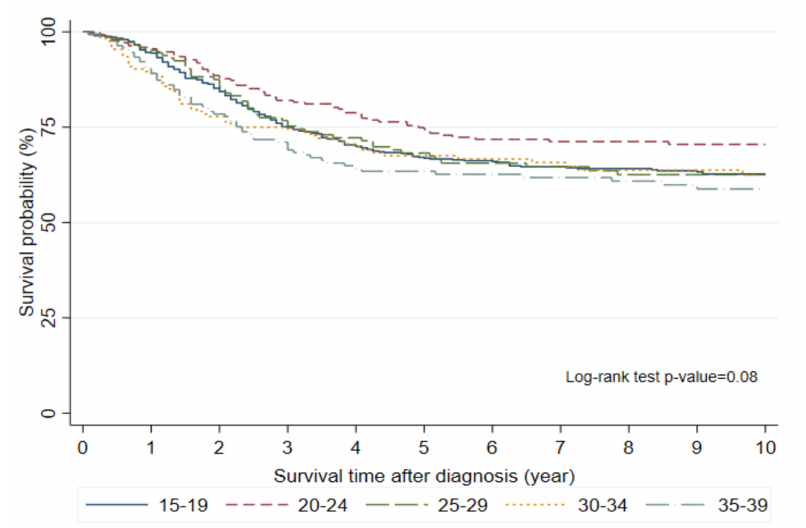
Figure 4. Overall survival of AYA by age